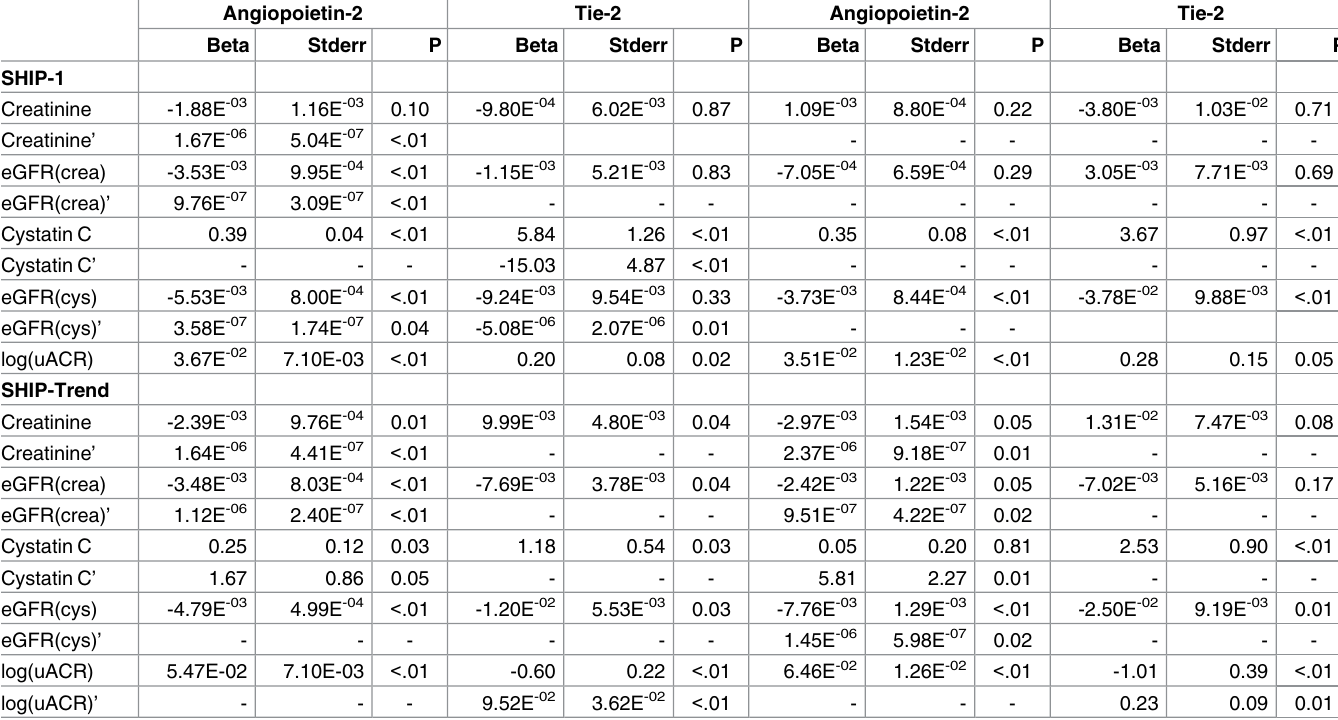
Table 2. Associations between markersof renal function and serum angiopoietin-2 concentration or serum Tie-2 concentration.